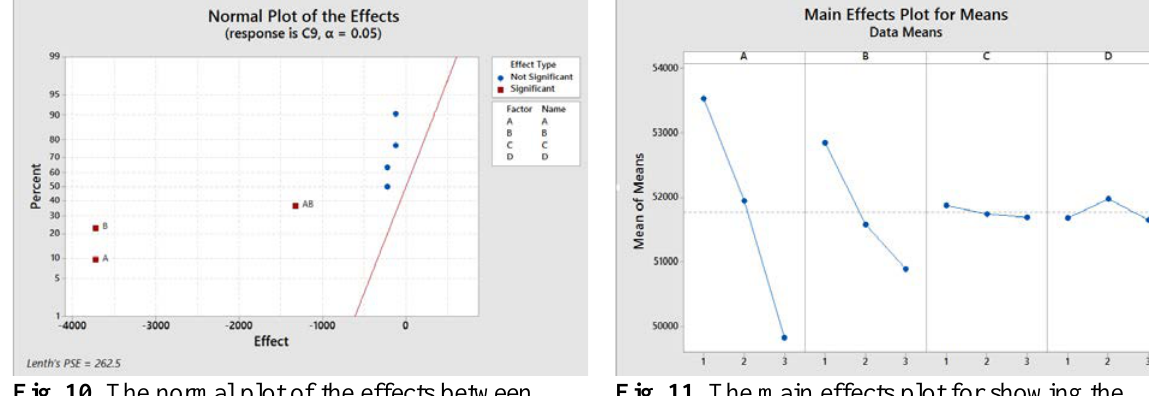
Fig. 11. The main effects plot for showing the impact of levels of input